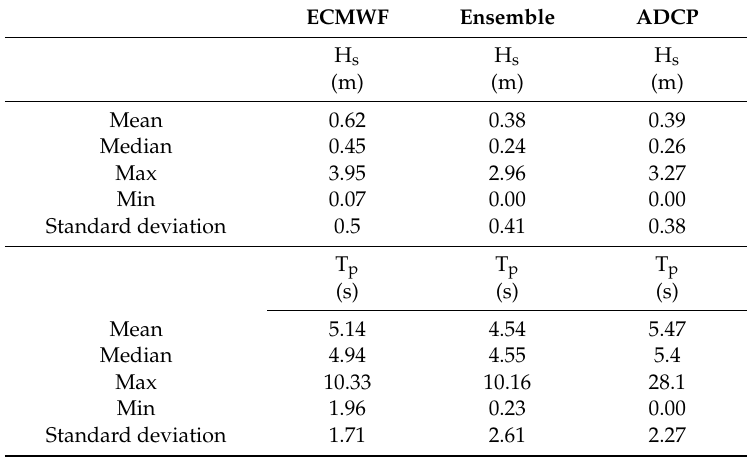
Figure 15. Wave rose referenced to different wave height classes (in legend) and related to the fictitious 1-year period for: ( a ) ECMWF grid point E3; ( b ) ADCP at MEDA A; ( c ) numerical model by using M220° only; ( d ) reconstituted time series by the five numerical domains. Table 9. Wave statistics obtained for the various sources.